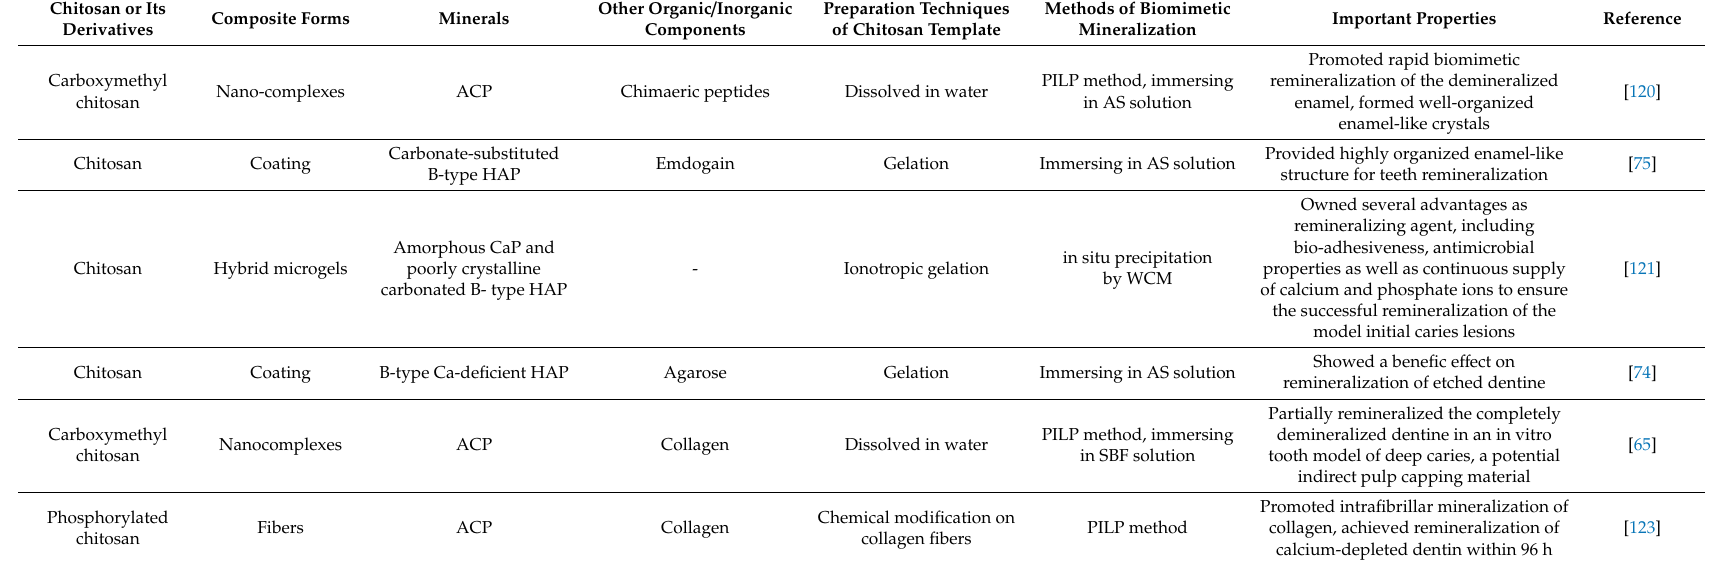
Table 2. Applications of chitosan-based biomimetically mineralized composite materials in dental hard tissue